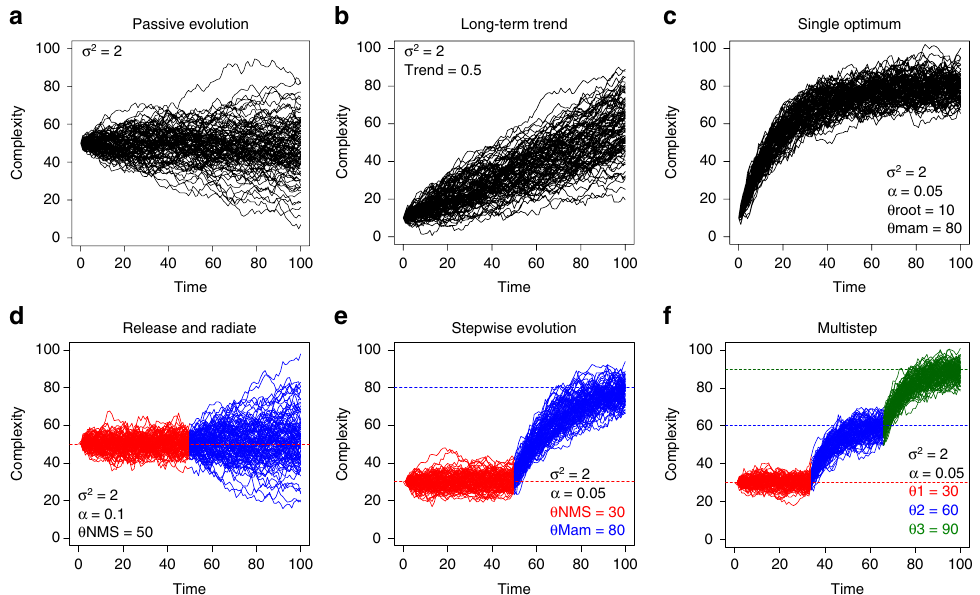
Fig. 1 Hypotheses for the evolution of vertebral complexity in mammals. a Random walk (BM model); b long-term continuous upward trend (BMtrend model); c selection toward a high optimum value in mammals (rooted OU1 model); d constrained evolution in non-mammalian synapsids followed by unconstrained radiation in mammals (RR model); e stepwise evolution toward higher optimum in mammals (OU2 model). f Multistep evolution with multiple optima shifts (e.g., OU3A and OU3B) Table 1 Summary of evolutionary